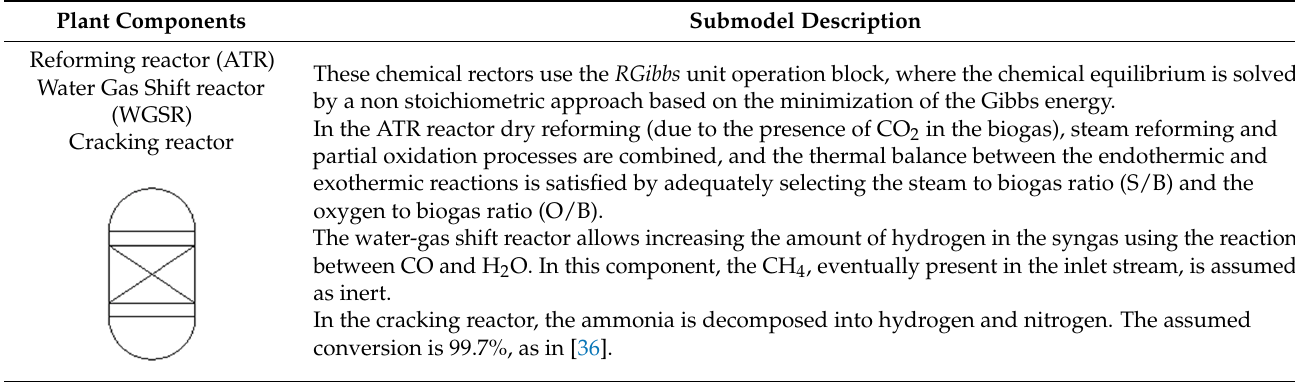
Table A1. Details on the unit operation blocks used for modelling the components of the plants. Submodel Description